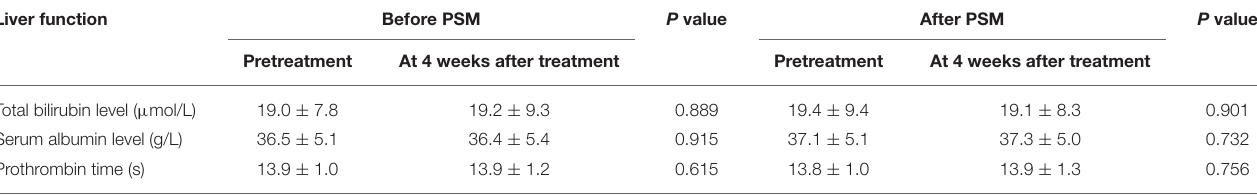
TABLE 3 | Liver function changes at 4 weeks after treatment in the TACE–apatinib group before and after PSM analysis. Liver function Before PSM